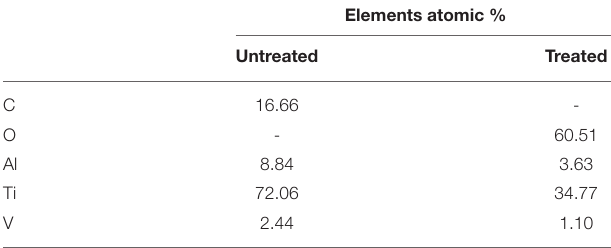
TABLE 1 | EDS analyses on untreated and treated cup